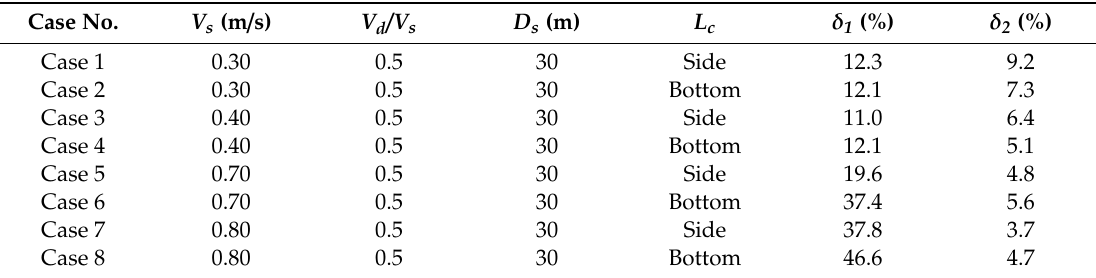
Table 2. Eight additional cases for the hidden-point test and the corresponding errors of the metamodel for the boundary arrival time ( t b